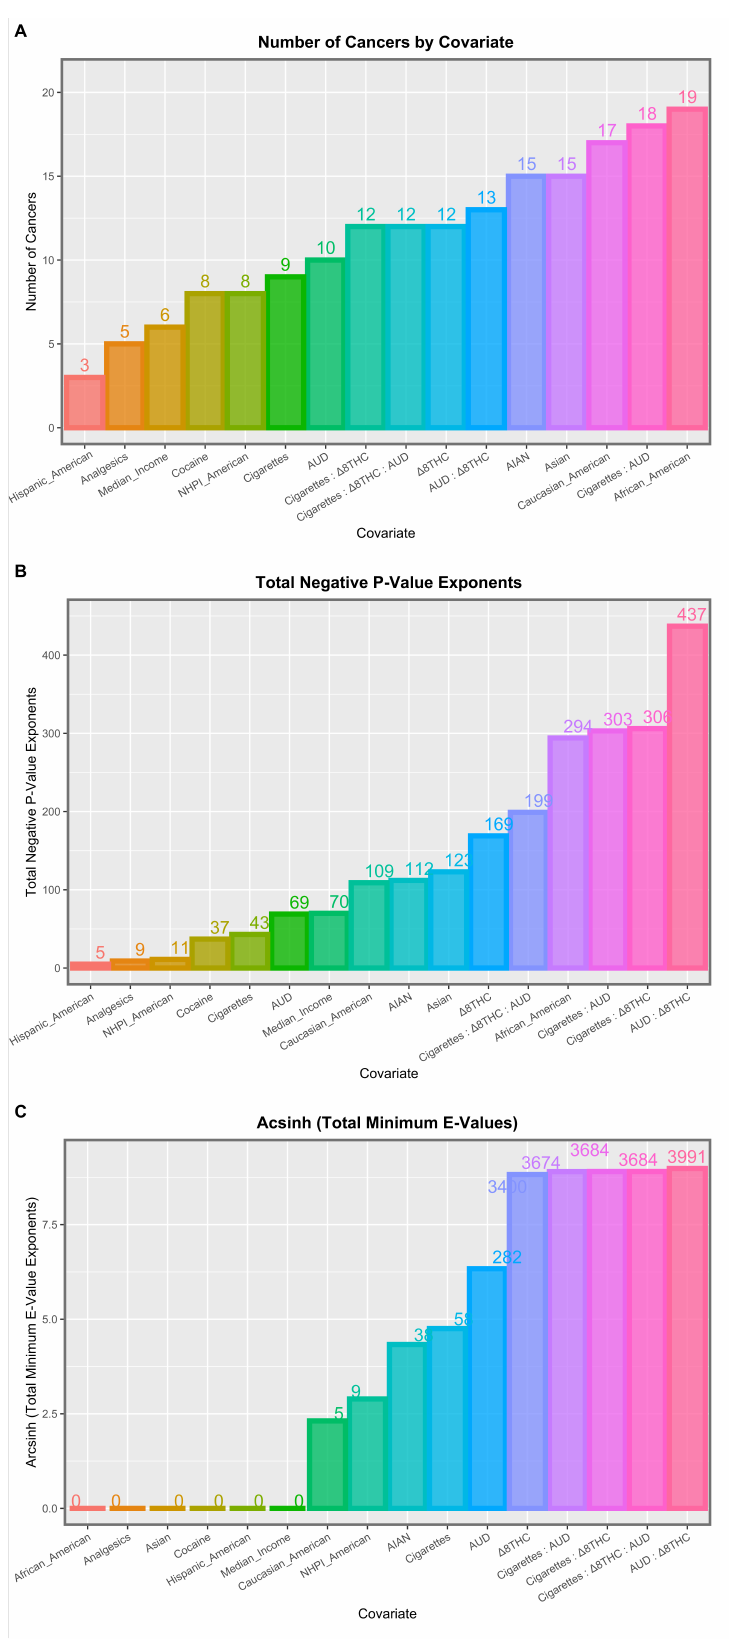
Figure 4. Summary graphs for the interactive multivariable panel models at four years of